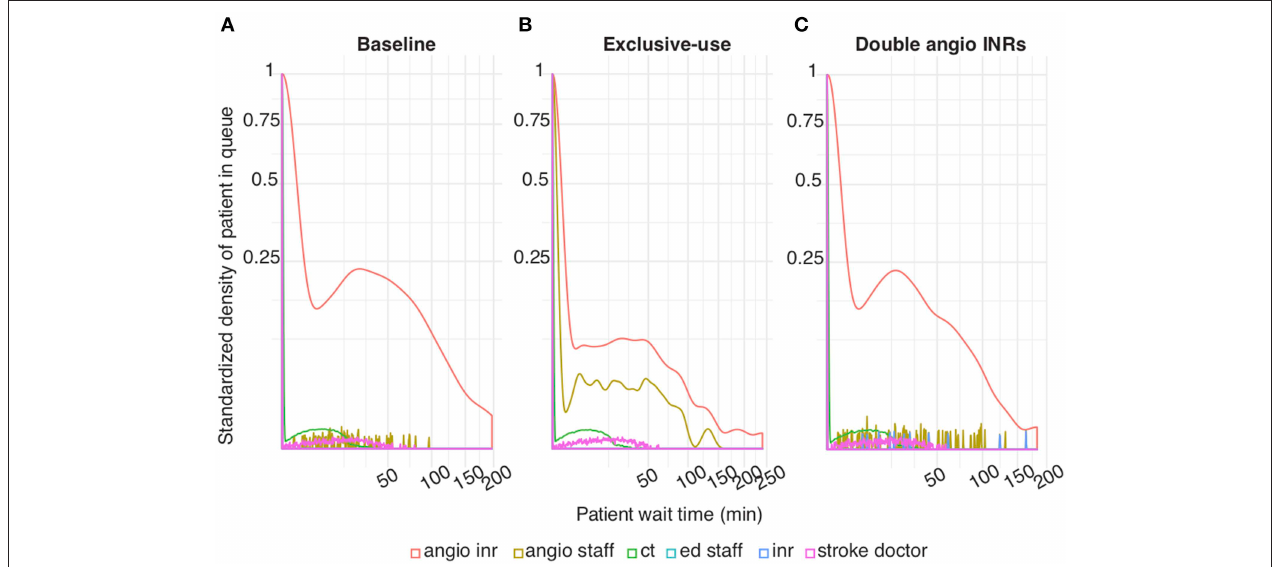
FIGURE 2 | Patient wait time under various simulation scenarios (A) . Baseline scenario simulated using inputs from Table 1 (B) . Exclusive-use scenario: IR patients can only utilize angioIR (C) . Two angioINRs scenario: 2 angioINRs, no angioIRs. Standardized density of patients in queue: the probability density of patients who are waiting standardized to patients who are not waiting.